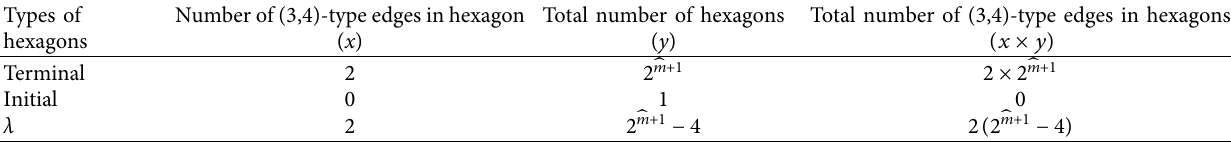
Table 8: The total number of (3,4)-type edges in hexagons of ζ .